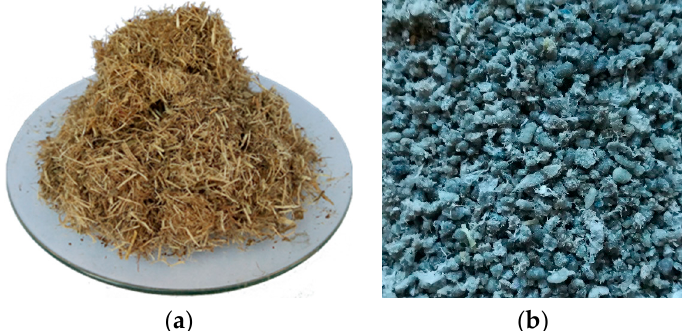
Figure 1. ( a ) Milled whole-tree biomass of A. saligna and ( b ) rLDPE.